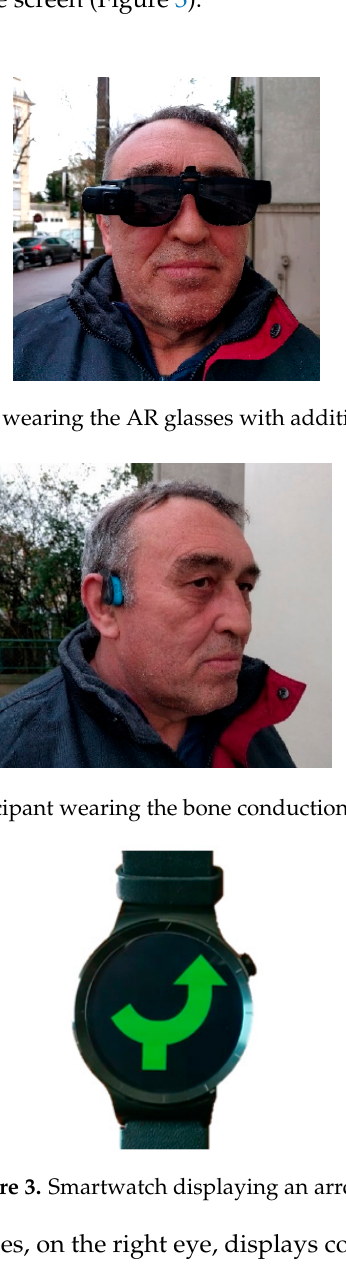
Figure 2. Participant wearing the bone conduction headphones.